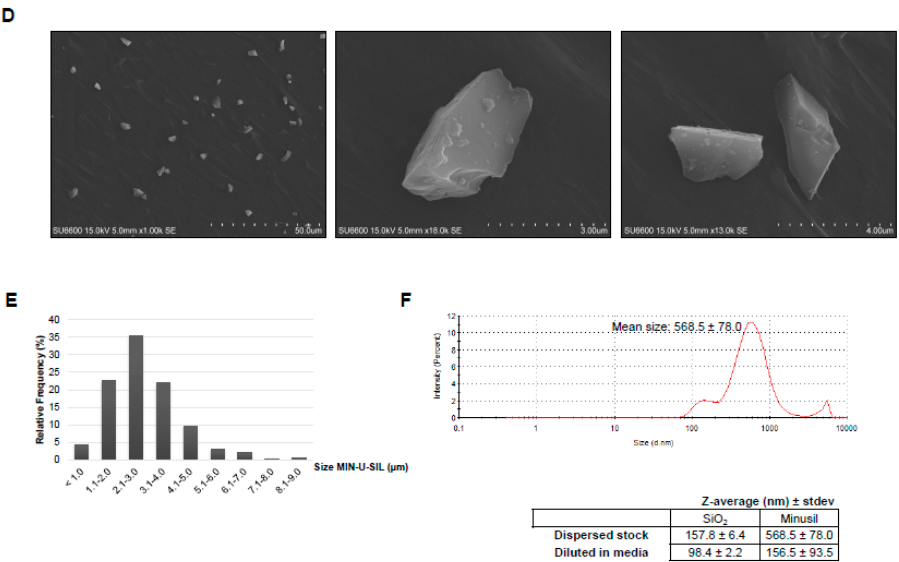
Figure 2. Characterization of the dispersed dust. A volume corresponding to 100 µ g dust was taken from a 1 mg/mL stock dispersed in 0.05% BSA and filtered through a 47 mm Whatman Nuclepore polycarbonate filter with 15 nm pore size. The dust was investigated by SEM and representative images are shown for ( A ) amorphous SiO 2 and ( D ) crystalline SiO 2 ; ( B ) The diameter (nm) of the dust particles was measured and the relative frequency in percentage is shown for the different size groups ( n = 300); ( C ) Size distribution and average hydrodynamic diameter of the dispersed amorphous SiO 2 dust; ( E ) The diameter ( µ m) was investigated for crystalline SiO 2 ( n = 300); ( F ) Size distribution and average hydrodynamic diameter of the dispersed crystalline SiO 2 dust. For the dynamic light scattering (DLS) measurements one ml of the dispersed stock solution was to obtain the size distribution and average hydrodynamic diameter. 10 cycles were run and the graphs show the size distribution, which is representative of one measurement over 10 cycles. To sum up the Z-average from three independent dispersed batches is shown ± standard deviation (SD) for both the dispersed stocks and dispersed dust diluted in cell culture